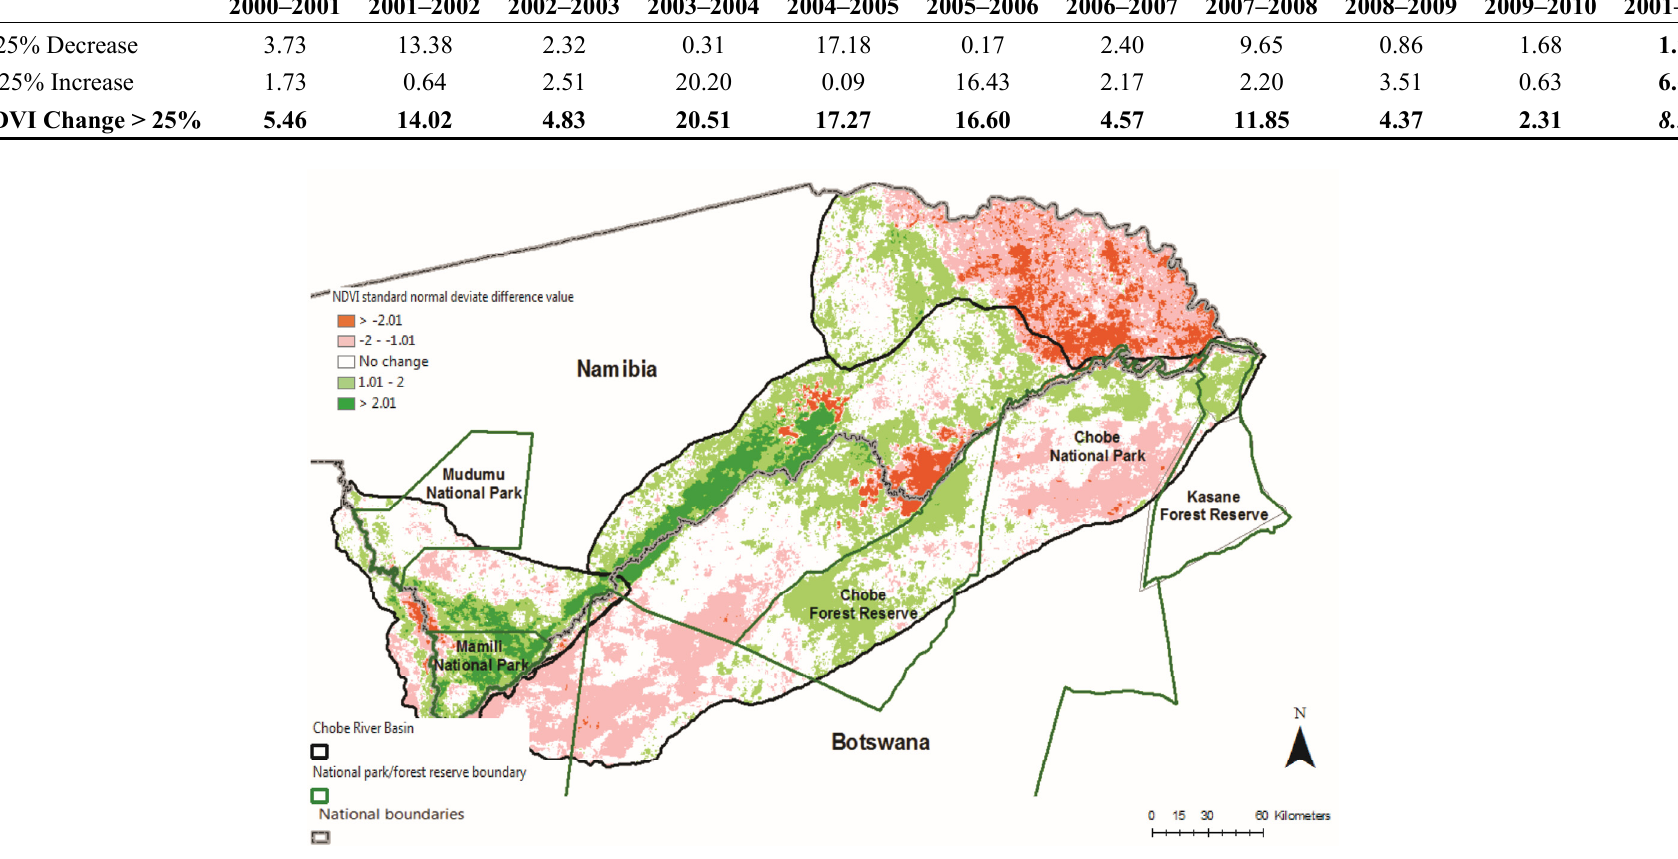
Figure 9. Two-date standardized NDVI change detection (2000 to 2009) for Chobe Basin area based on MODIS g.s. NDVI data. Areas in green indicate increases in vegetation productivity in 2009 versus 2001, while areas in shades of red indicate lower vegetation productivities in 2009 as compared to